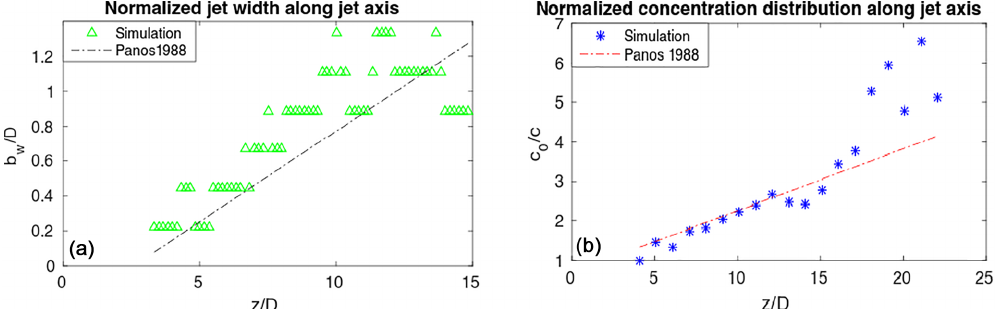
Figure 8. Panel (a) shows normalized jet width (which determined based on velocity) along the centerline. Panel (b) shows normalized concentration along the centerline.